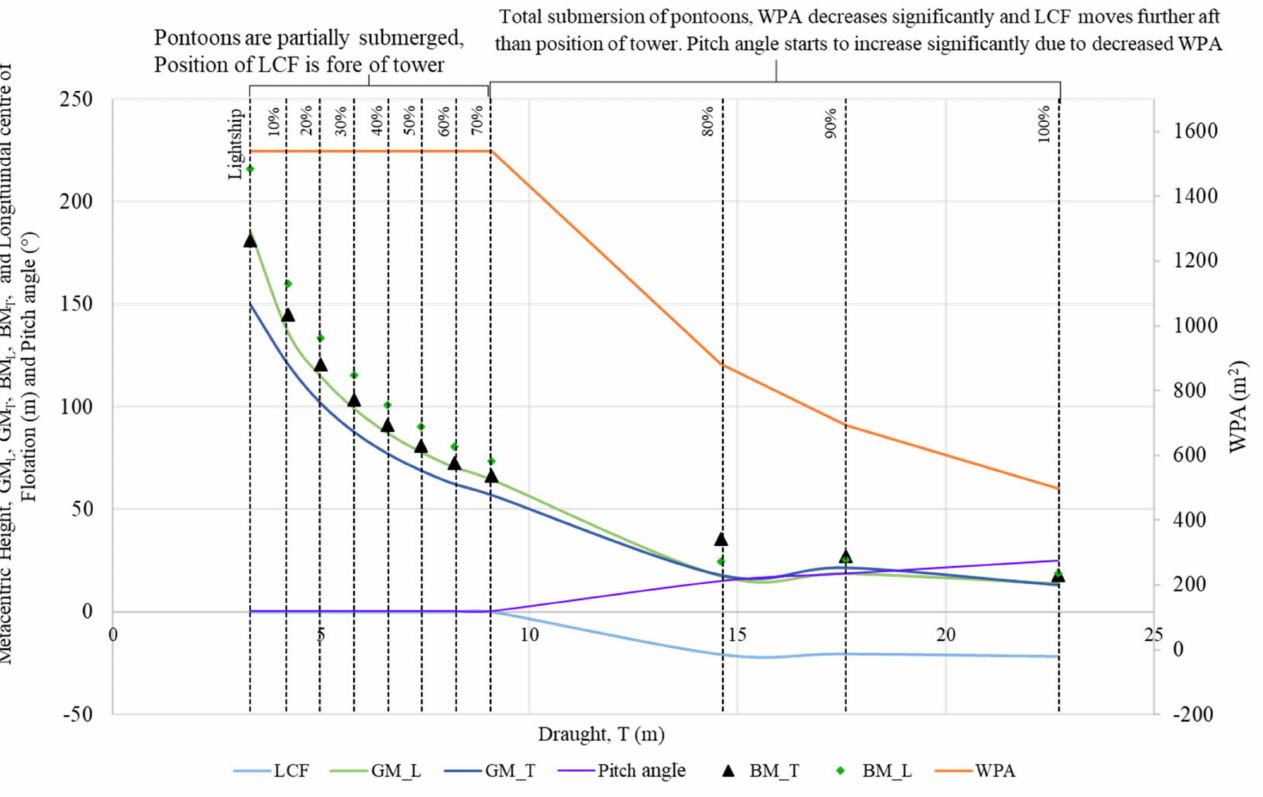
Figure 11. Effect of WPA on